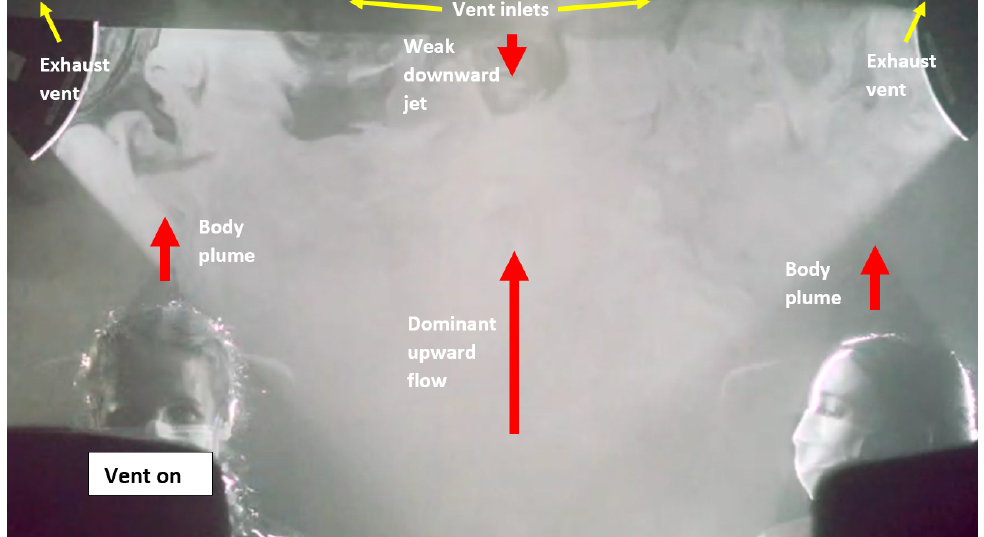
Figure 14. Snapshot of flow visualisation experiment at end of carriage during ventilated conditions. Red arrows indicate direction of persistent air flow. Yellow lines indicate location of inlet and extract